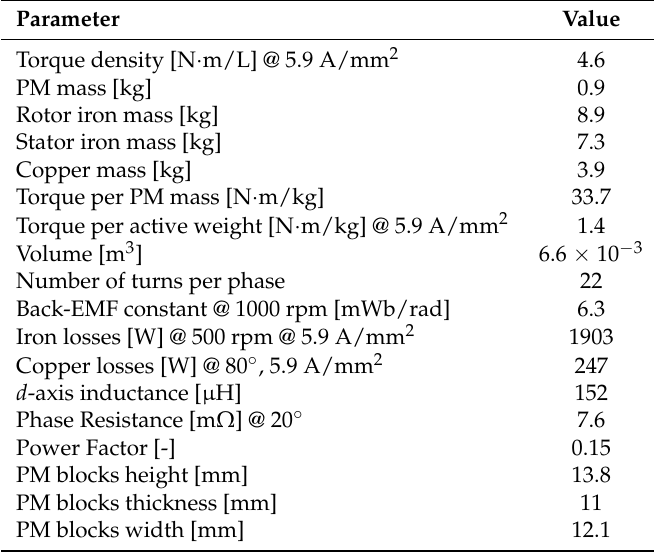
Table 3. Main dimensions of the HM3D